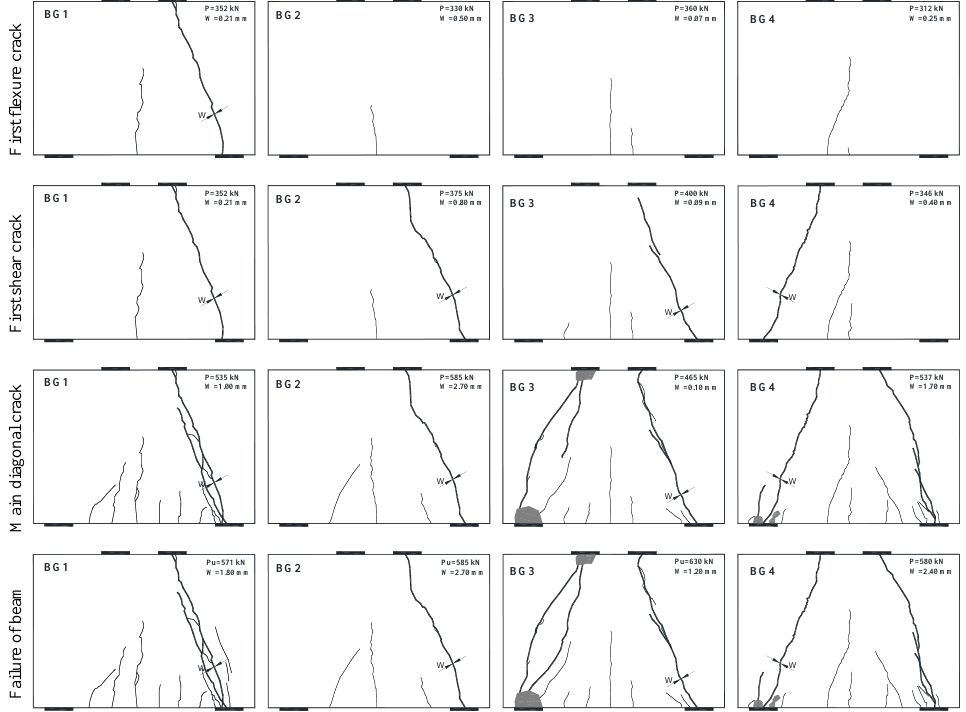
Figure 17: Crack development and mode of failure for the deep beam with GFRP web reinforcement.